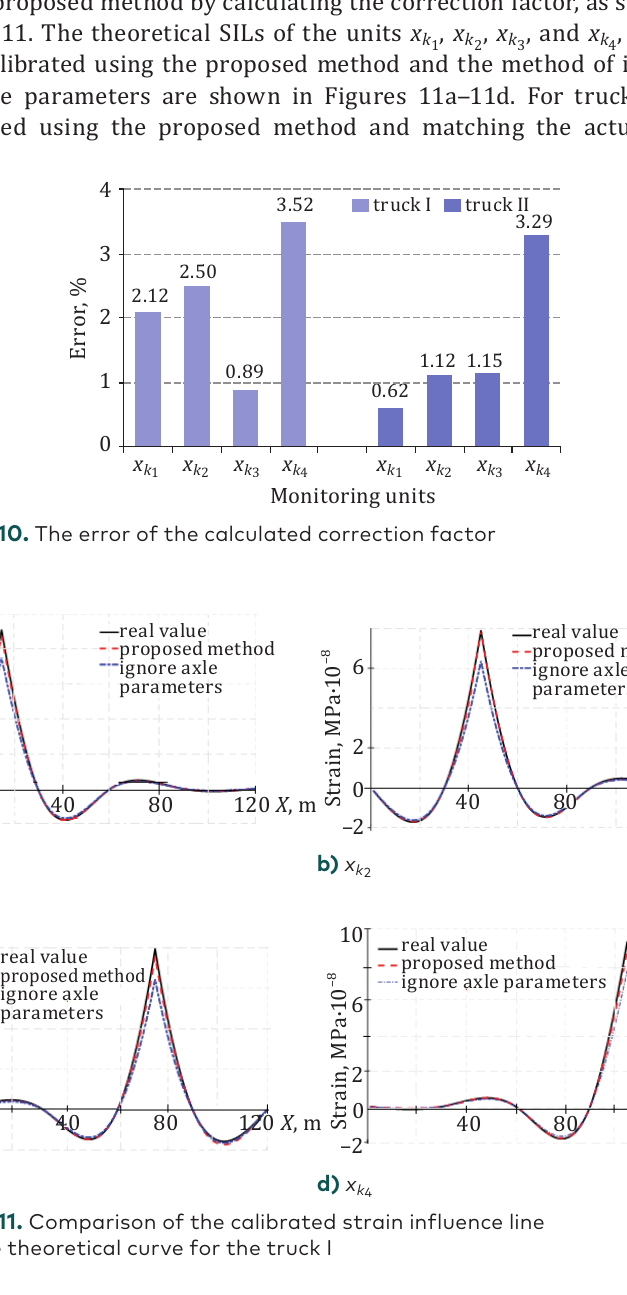
Figure 11. Comparison of the calibrated strain influence line and the theoretical curve for the truck